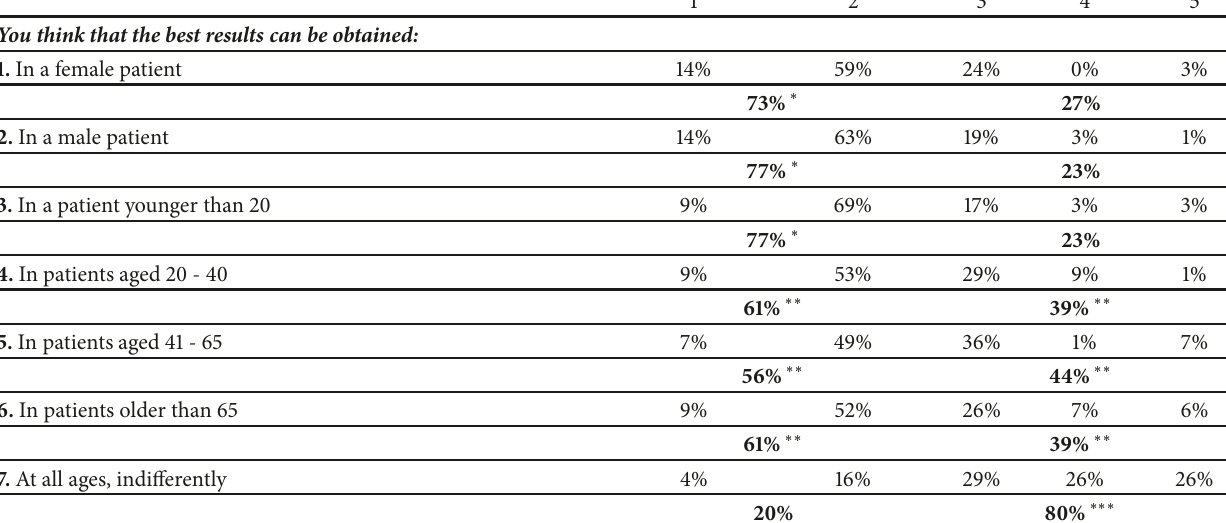
Table 6: Results of the Consensus Conference on the use of betahistine related to gender and age. 1 = absolutely disagree, 2 = disagree, 3 = agree, 4 = more than agree, and 5 = absolutely agree. Consensus was reached when the sum of items 1 and 2 or 3, 4, and 5 reached 66%. Same asterisk convention.